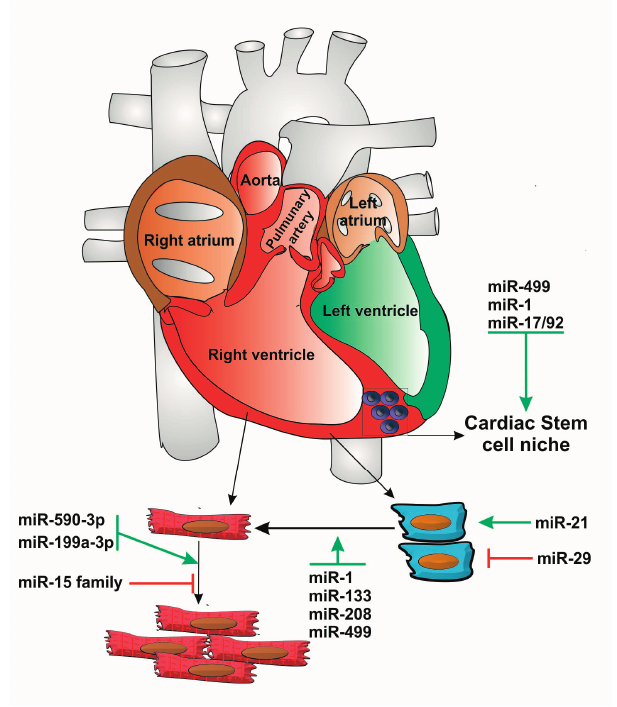
Figure 6. miRNAs in the definition of cardiac cell fate. Niches of cardiac stem cells in the postnatal heart have the potential to differentiate into several cellular lineages that compose the heart. miRNAs can impact on heart regeneration by modulating the cellular fate of these resident cardiac progenitor cells and other cardiac cell types, in particular cardiac muscle cells and cardiac fibroblasts. Heart regions are colored according to their developmental origin: red—first heart field; green—second heart field; brown—both heart fields. See text for